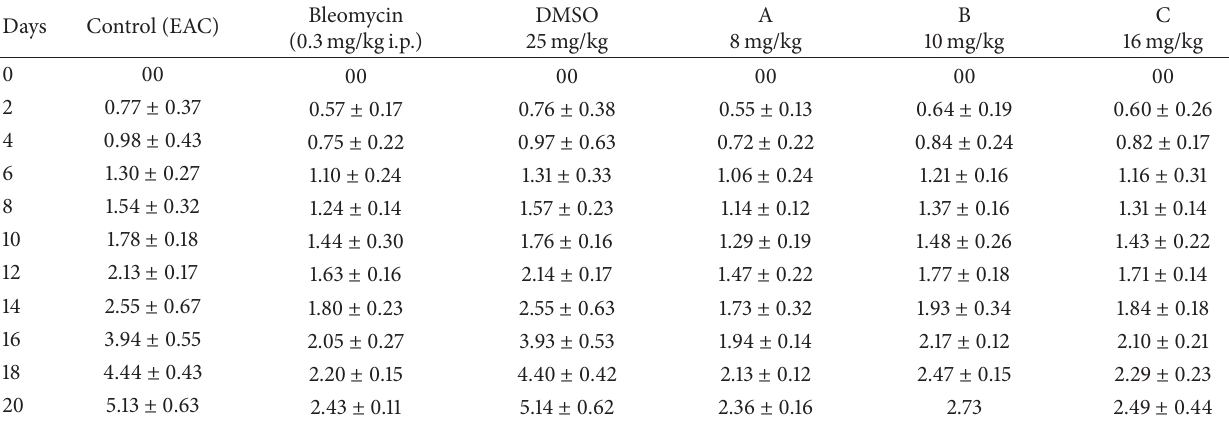
Table 6: The effect of test compounds on survival time of EAC cell bearing mice.